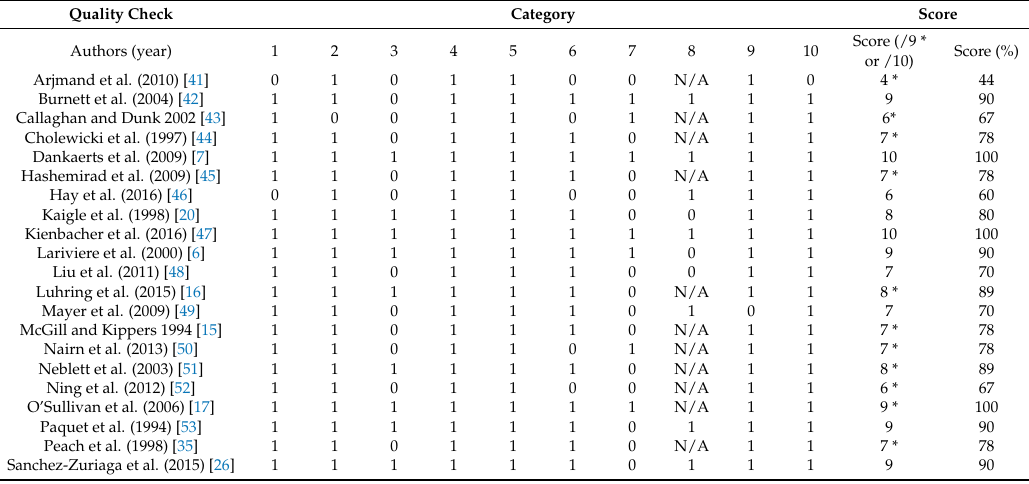
Table 1. Quality index assessment scores (* Studies that did not compare healthy controls to a low back pain group were rated using a 9 point scale instead of